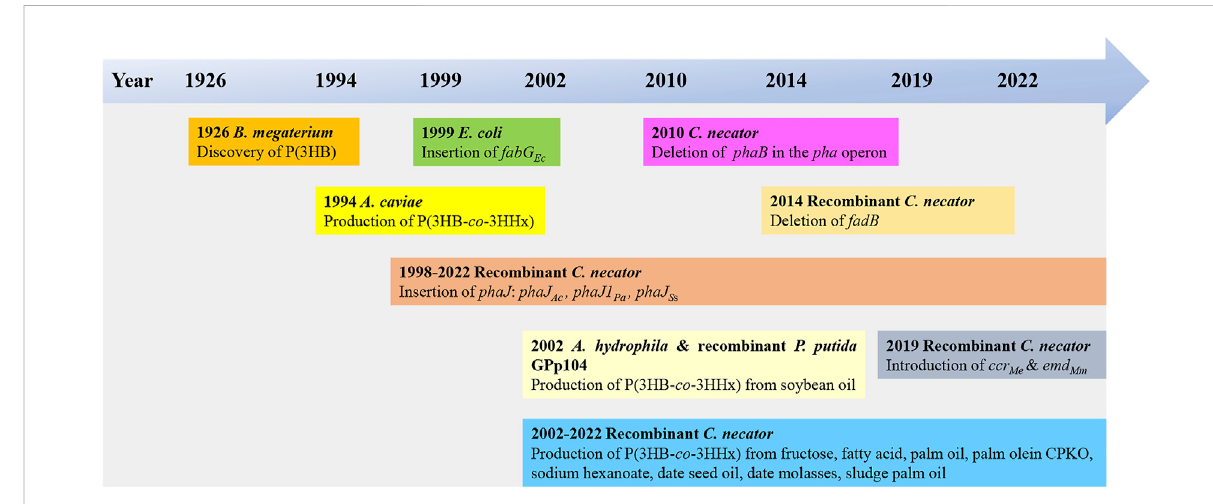
FIGURE 1 TimelineoftheP(3HB- co -3HHx)developments(Lemoigne,1926;Shimamuraetal.,1994;Fukuietal.,1998;Asraretal.,2002;Fukuietal.,2002; Tsuge et al., 2004; Loo et al., 2005; Budde, 2010; Wong et al., 2012; Insomphun et al., 2014; Volova et al., 2016; Murugan et al., 2017; Purama et al., 2018; Thinagaran and Sudesh, 2019; Zhang et al., 2019; Tan et al., 2020; Tan et al.,